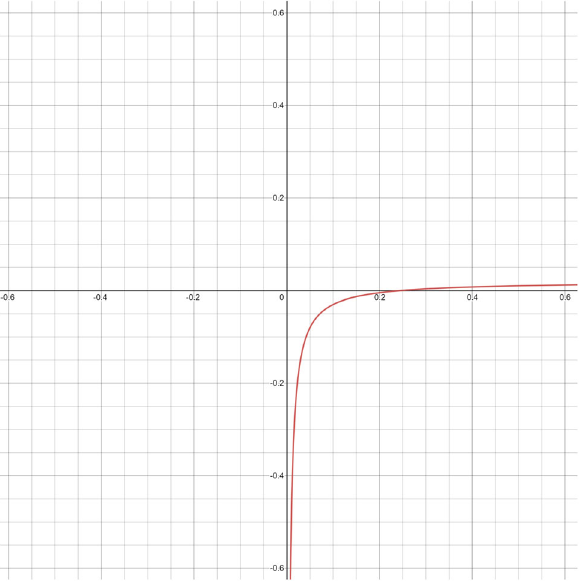
Fig. 1 Δ fin becomes negative around ω ∼ 0 . 25, then sharply diverges as ω approaches zero. (Here we let M = 1, (cid:4) = ζ = 0 . 01)